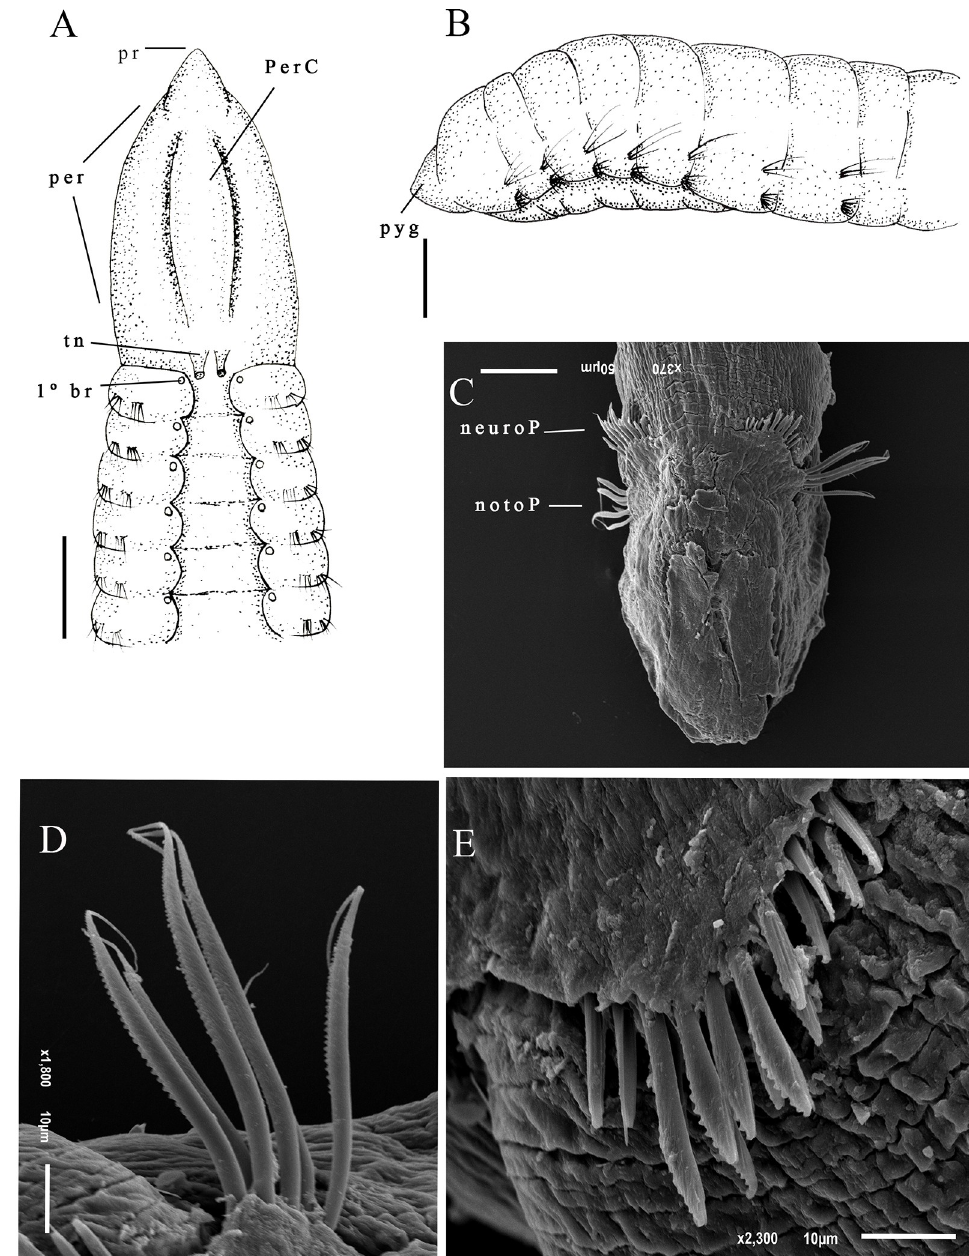
Fig 9. Kirkegaardia nupem sp. nov. (A) anterior end, dorsal view; (B) posterior end, lateral view; (C) posterior end with tube, ventral view; (D) notopodial setae in posterior region; (E) neuropodial setae in posterior region. A and B (MNRJP- 003003). Scale bars: 100 μ m (A and B). Type locality. Atlantic Ocean: Campos Basin (Brazil). Habitat. Sandy sediments with or without biodebris, 46 to 1010 m depth. Distribution. Presently known only from Atlantic Ocean: Campos Basin (Brazil). Methyl Green. No pattern, stain not